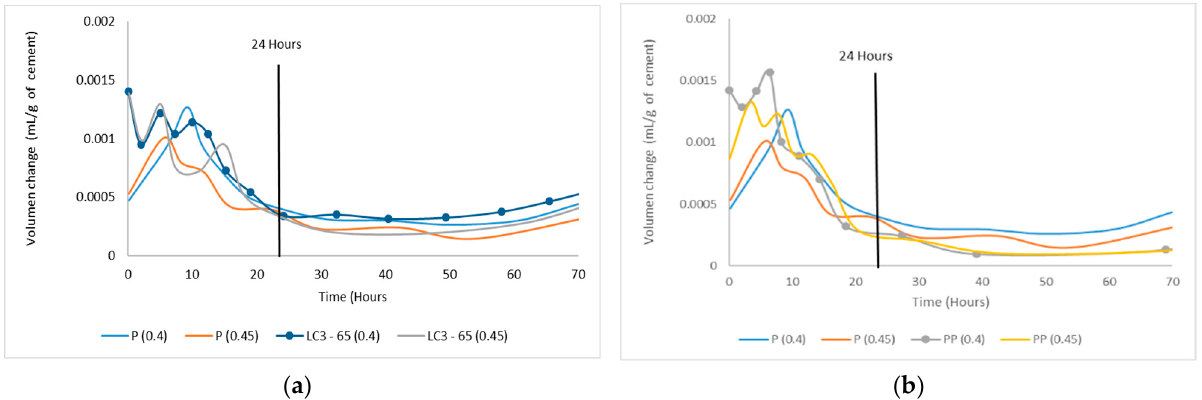
Figure 2. Effect of water/cement ratio on volume changes in paste: ( a ) combinations of OPC and LC2 binder, ( b ) pozzolanic cement containing 15% of natural pozzolan binder (PPC).